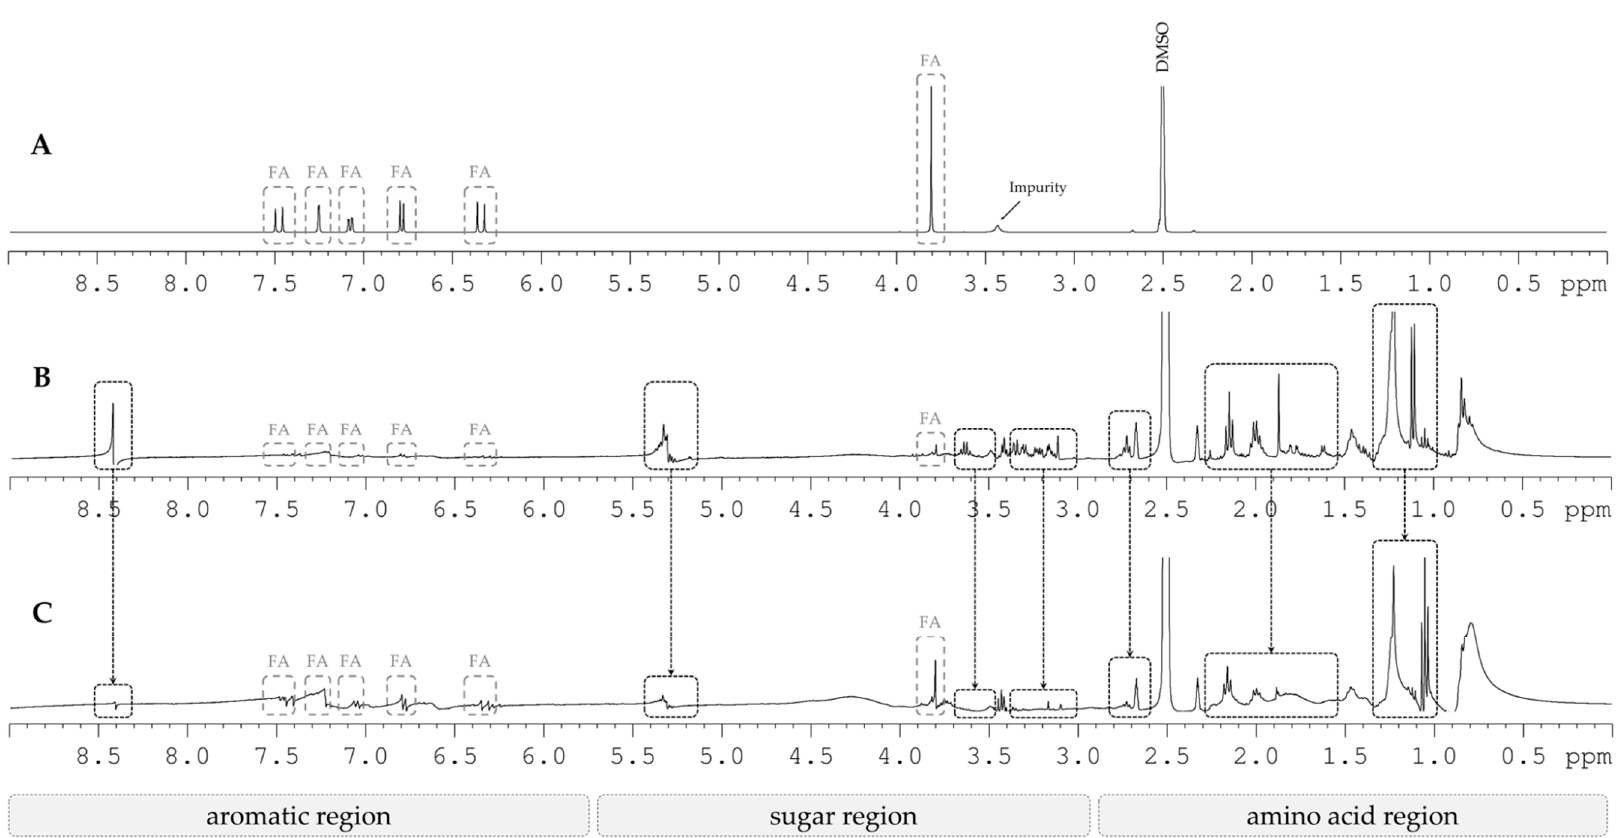
Figure 4. 1 H NMR spectra for ( A ) ferulic acid standard, ( B ) initial extract obtained by alkaline hydrolysis of BSG in autoclave with simplified post-extraction process and ( C ) final extract partially purified by adsorption/desorption in the Lewatit resin. Peaks corresponding to ferulic acid are marked in a grey box with the inscription “FA”. The black boxes indicate the regions where the differences were more significant. The arrows make the correspondence between initial and final extracts.